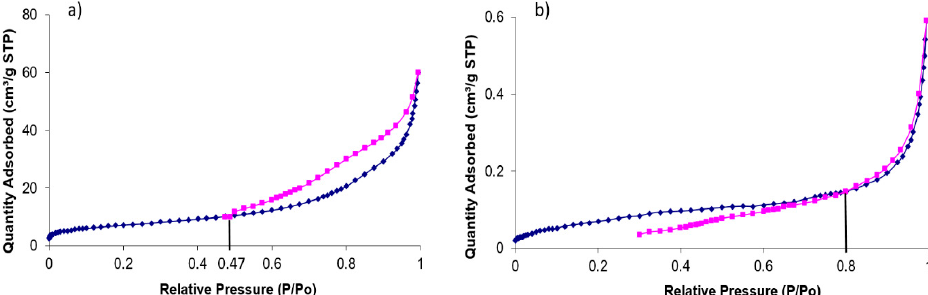
Figure 1. Nitrogen adsorption–desorption isotherms of ( a ) 5%rGO / Bi and ( b ) bismuth subnitrate.